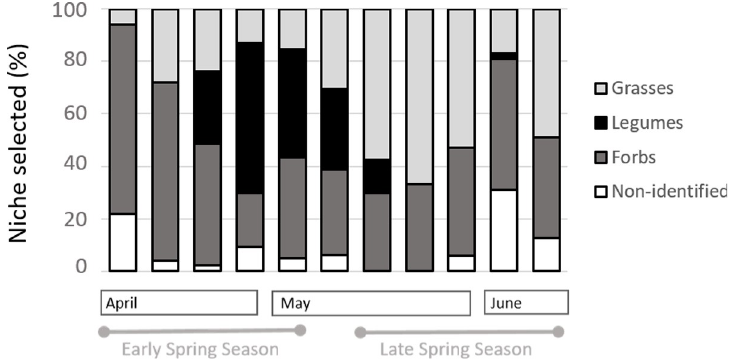
Variation in the Pi among weeks was very high for legumes (Table 4), evidencing a strong tendency to ignore legumes at the beginning of the vegetative stage and again at more mature stages. Forbs were preferred to other vegetation types in most weeks. The Pi for forbs and legumes was, on average, higher in early spring than in late spring, when preferences for those groups were close to zero. At this stage, the proportion of feeding time on forbs and legumes equals the proportion of area covered by the same plant functional groups. The Pi for grasses in both seasons was similar and close to zero, meaning that this functional group was never selected or avoided, thus indicating that the intake rate is dependent on the frequency with which the animal encounters grasses.